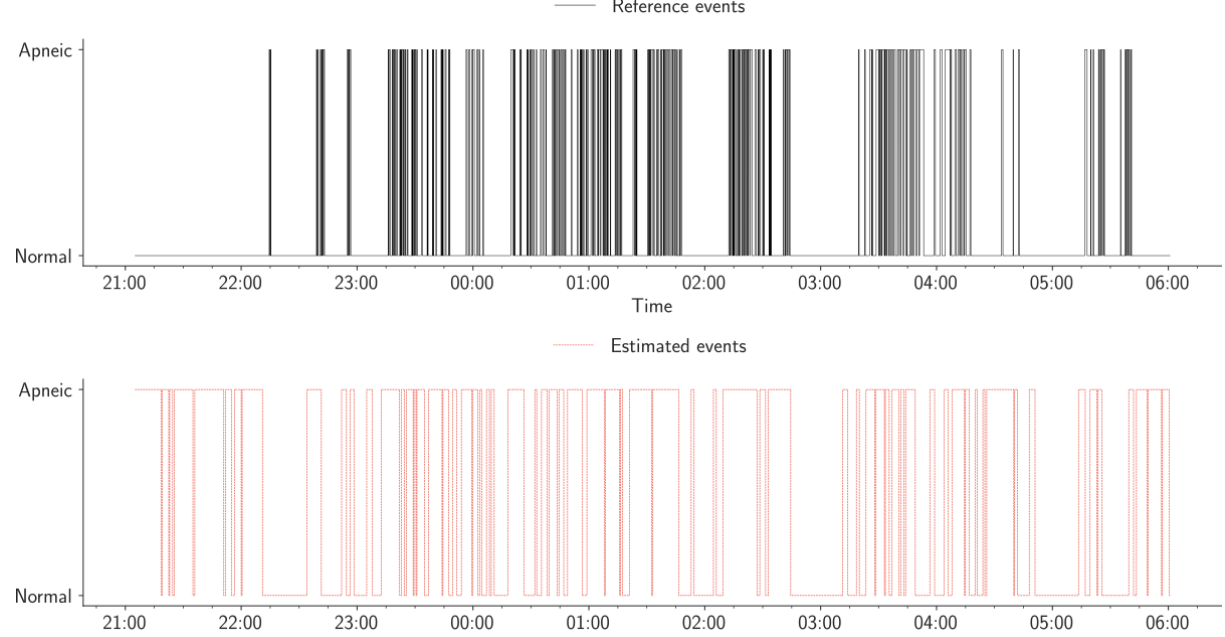
Figure 17. Annotation of apneic events for the first patient. The first row describes the reference events (apnea-hypopnea index is 36.8 events per hour), whereas the second row describes the estimated events (apnea-hypopnea index is 23 events per